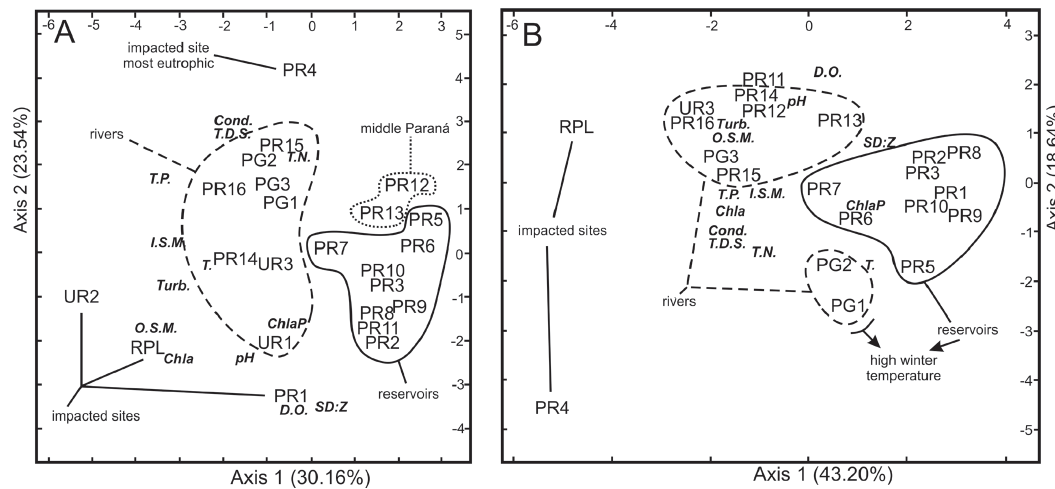
Figure 2. Bi-plot graphs of the PCA analysis performed for summer (A) and winter (B) data. Variables: Cond = conductivity; Chl a = chlorophyll a ; Chl a P = periphyton chlorophyll a ; DO = dissolved oxygen; ISM = inorganic suspended matter; OSM = organic suspended matter; SD:Z = transparency; Turb = turbidity; TN = total nitrogen; TP = total phosphorus; TDS = total dissolved solids; T = water temperature. Sampling sites codes as in Table